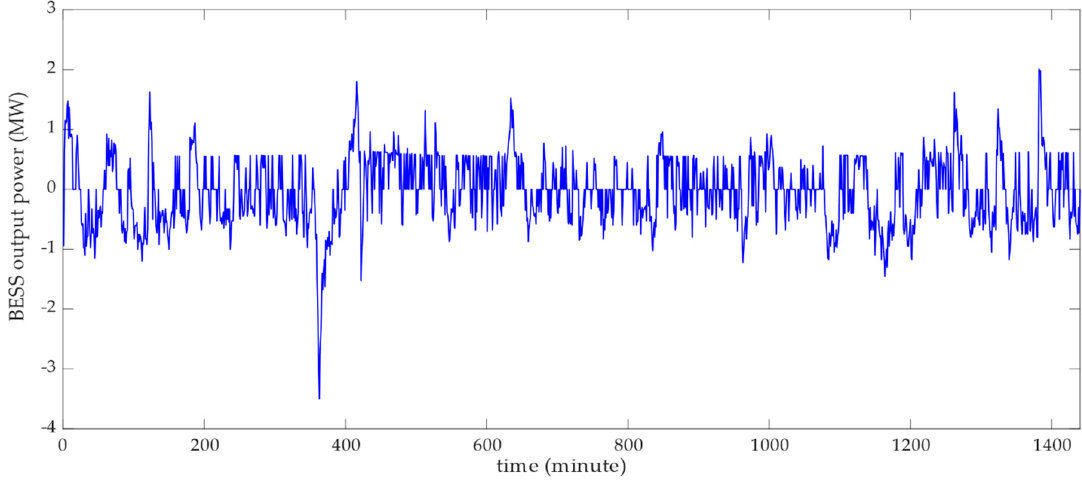
Figure 11. Battery storage power output using the proposed SoC DoF correction methodology.